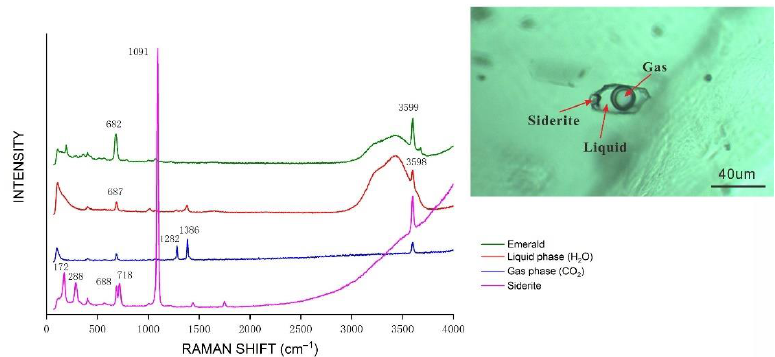
Figure 8. This hexagonal inclusion in Indian emerald clearly displays a gas bubble and a colorless crystal. Raman spectroscopy was used to identify the host emerald (green), the liquid phase: water (red), the CO 2 gas bubble (blue), and the siderite crystal (purple). The spectra are stacked for clarity.